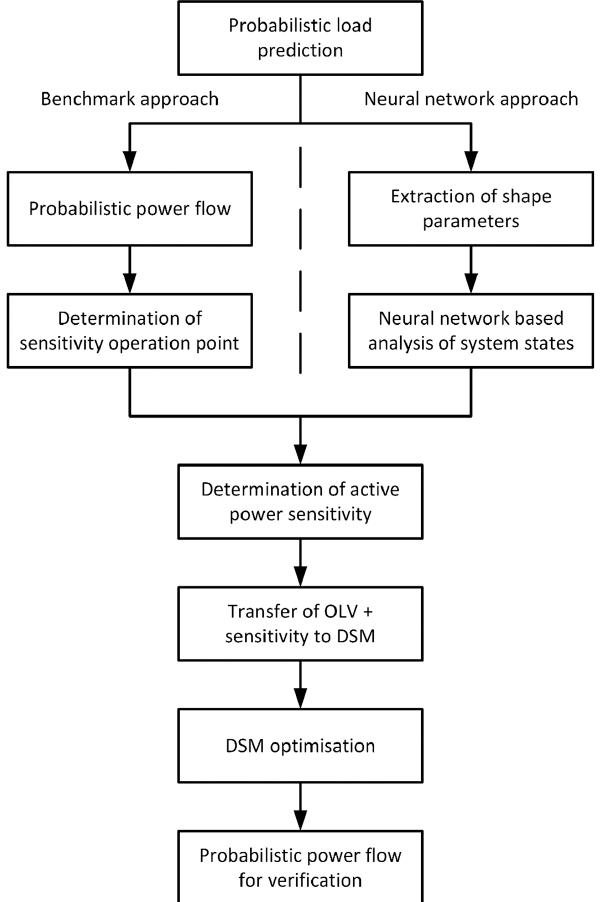
Figure 1. Comparison of the proposed grid-supportive DSM using PPF and machine learning.